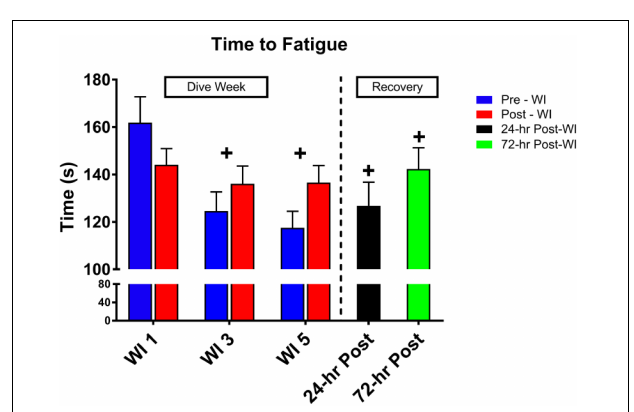
FIGURE 3 | Forty percent maximum handgrip endurance (MHE) time-to-fatigue results. Across subject ( n = 13) mean ± SEM is shown. Time-to-fatigue times dropped on WI 3 and did not recover by 72-h post-WI. “ + ” signifies day main effect ( p < 0.05).